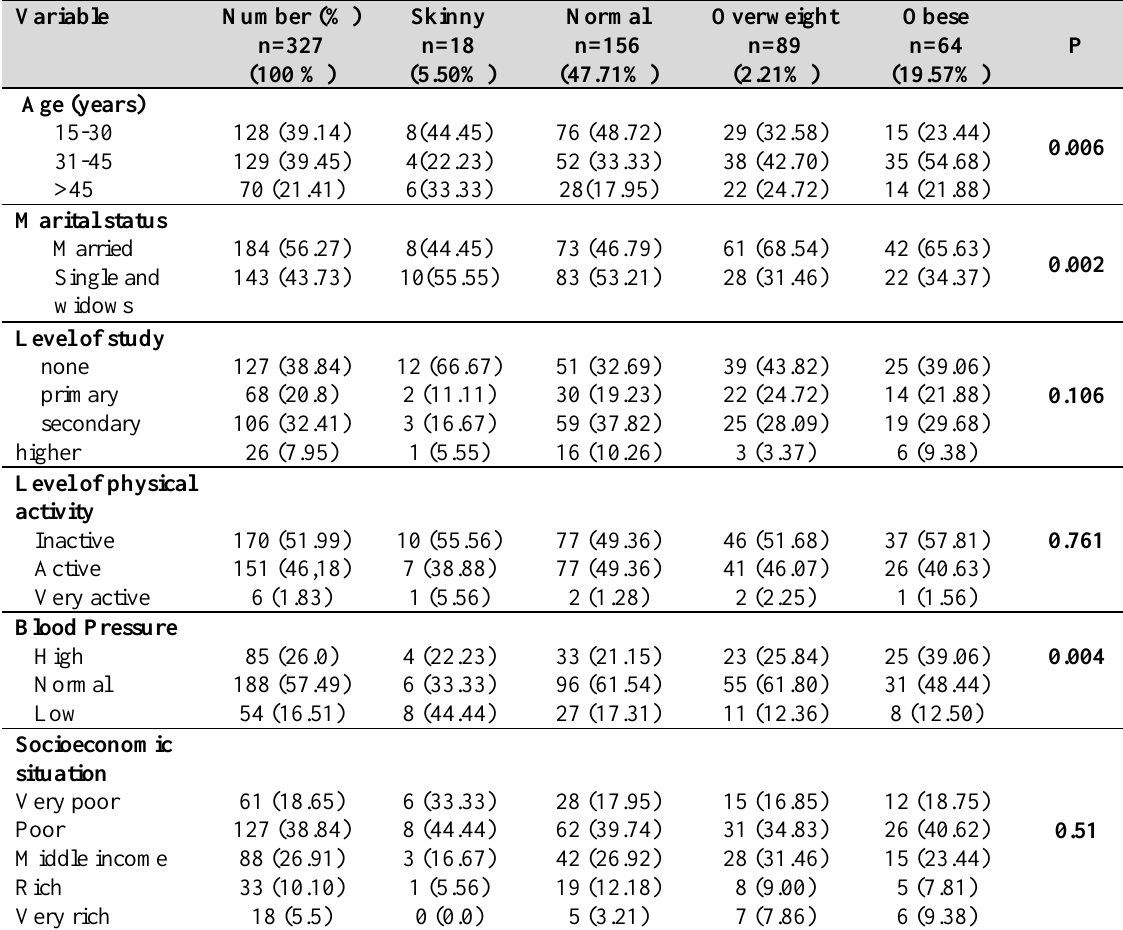
Table 1. Socio-demographic characteristics and association between women's BMI and the analyzed different factors in Anonkoi 3